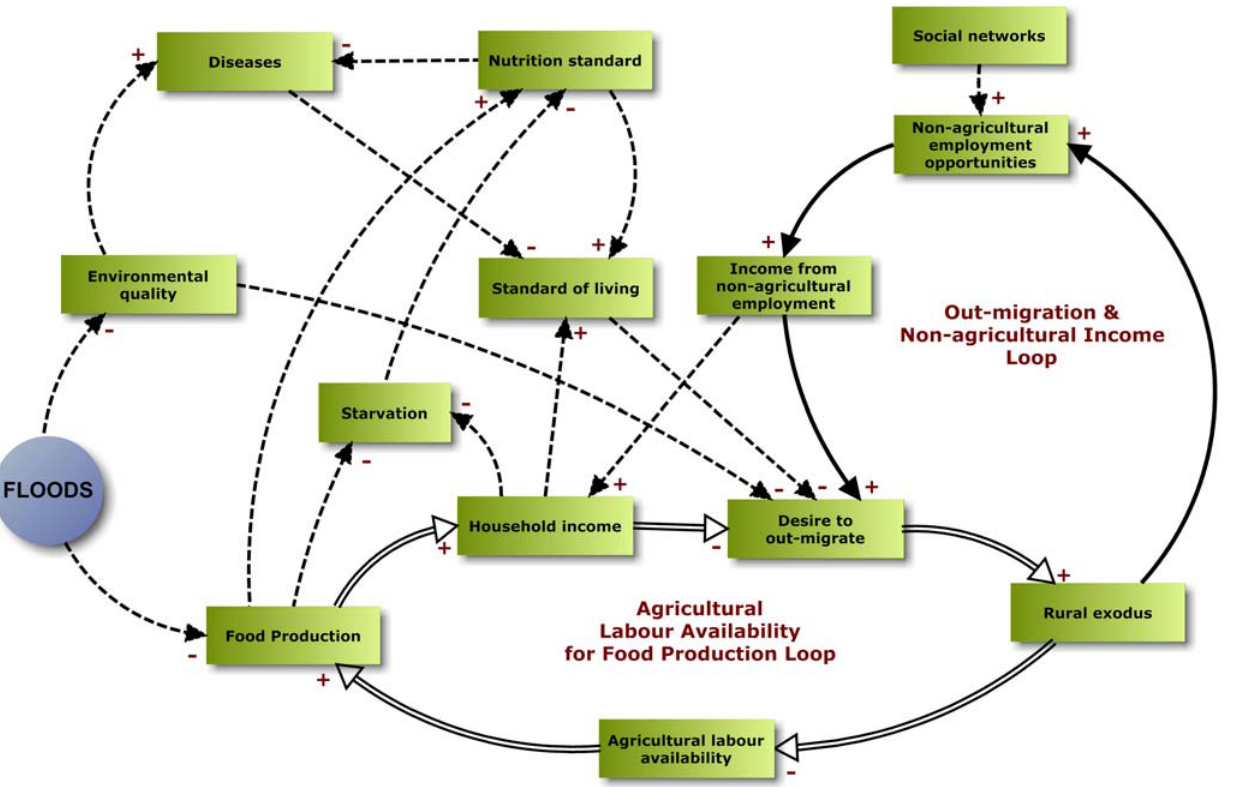
Figure 6. Rural-urban migration induced by